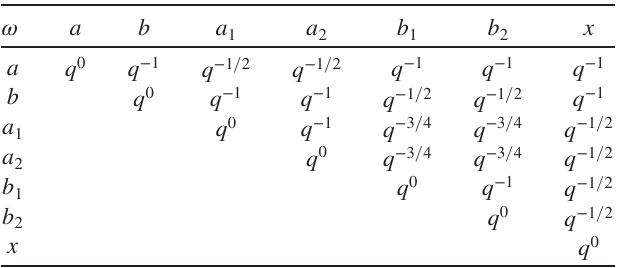
TABLE I. Upper bounds for the cost associated with the boundaries between the seven possible types of block contrac- tion. The matrix is symmetric, and so only the upper triangle is written